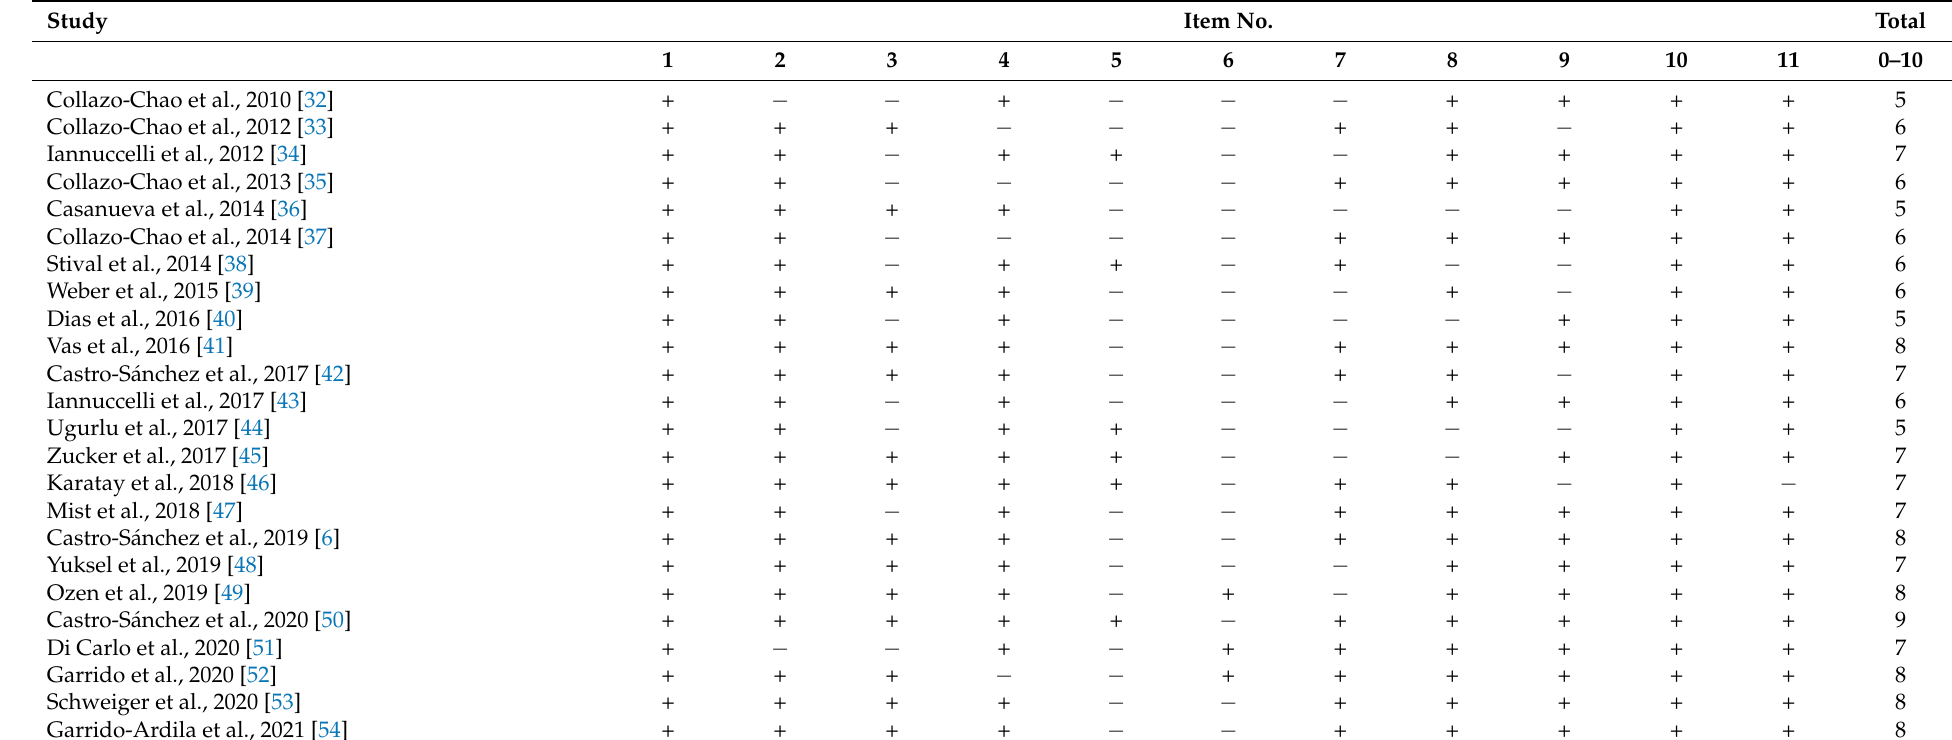
Table 1. Methodological Quality Assessment using PEDro Scale of the Included